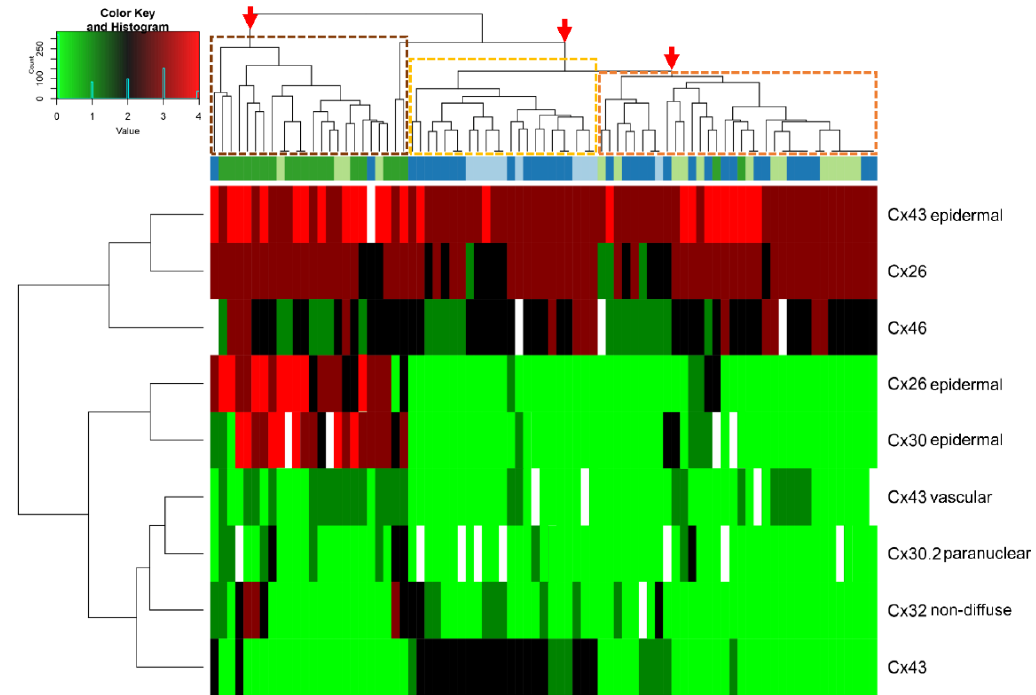
Figure 6. Unweighted hierarchical cluster analysis of connexin isotype expression in melanocytic tumor tissues and their microenvironments. Besides demonstrating tumor heterogeneity, three clusters (arrows) are separated from each other: (1) thick (dark green) and thin (pale green) melanomas (brown frame); (2) common (pale blue) and dysplastic nevi (dark blue; orange frame); and (3) a mixed group of thin melanomas and dysplastic nevi (light brown frame). Cases with missing data are in